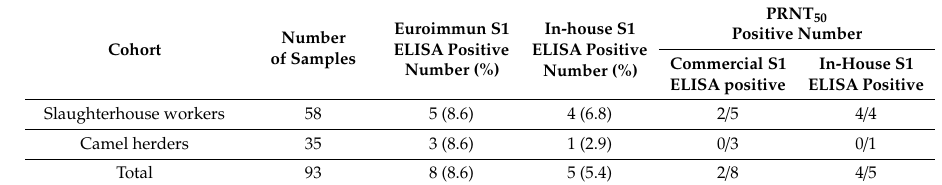
Table 1. The proportion of slaughterhouse workers and camel herders who were positive for MERS-CoV antibodies when tested by the Euroimmun ELISA, S1 ELISA and PRNT.